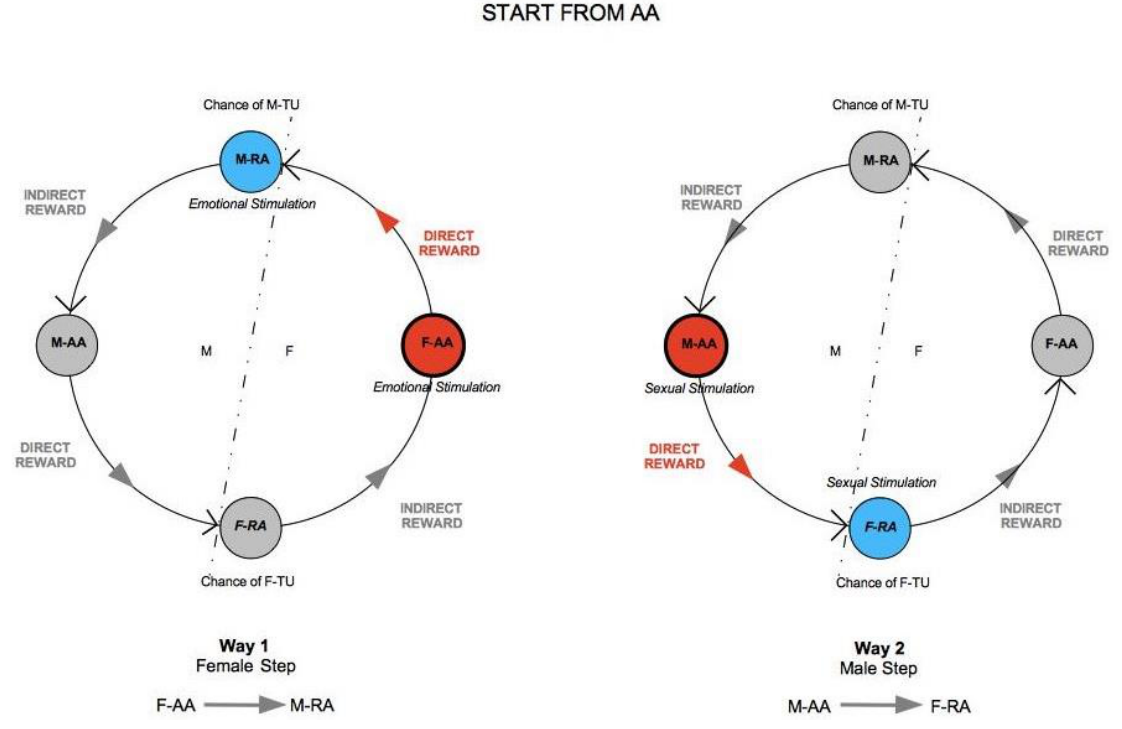
Figure 9. Ways Figure 9. Ways 1–2.